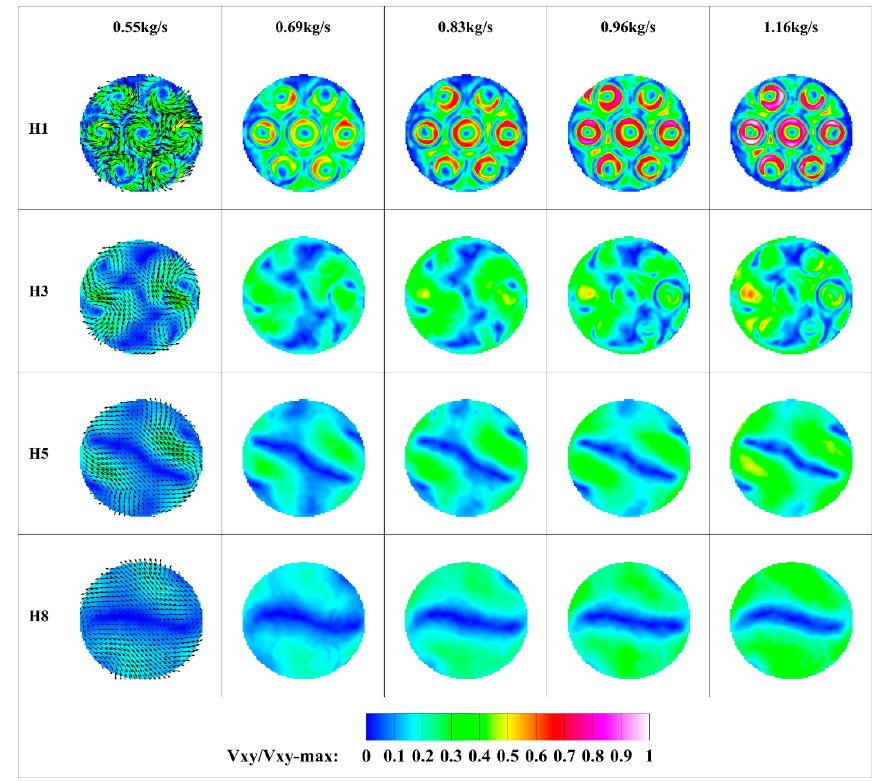
Figure 12. Experiment results: Cross-section contour.